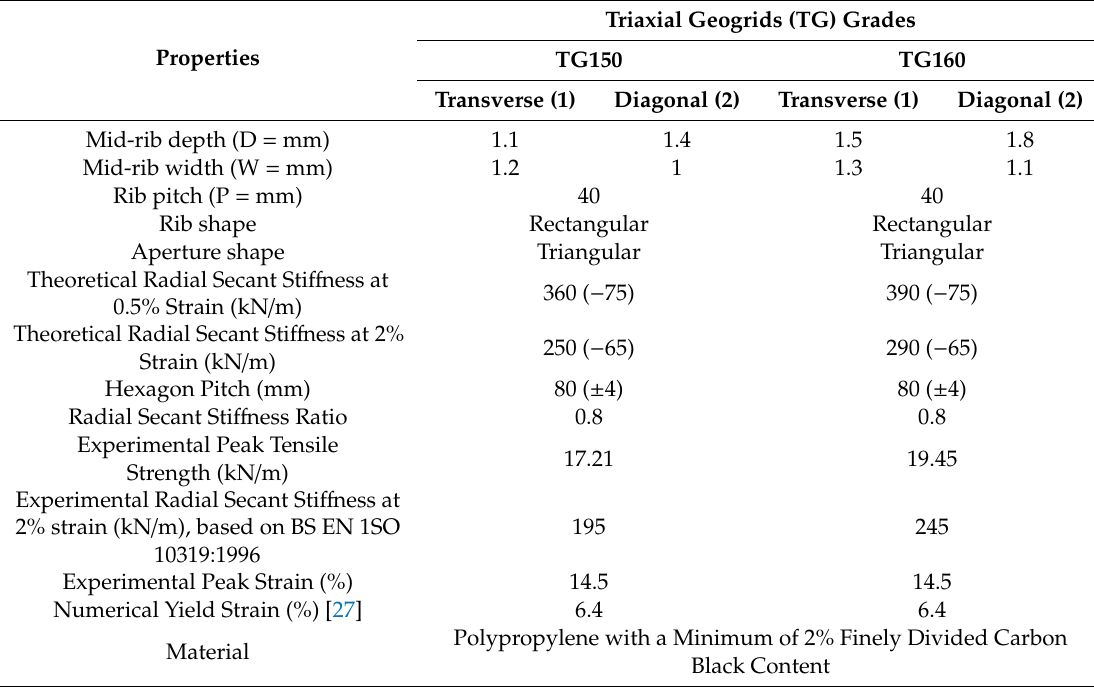
Table 4. Properties of the triaxial geogrids by the manufacturer, experimental tests, and numerical analysis.